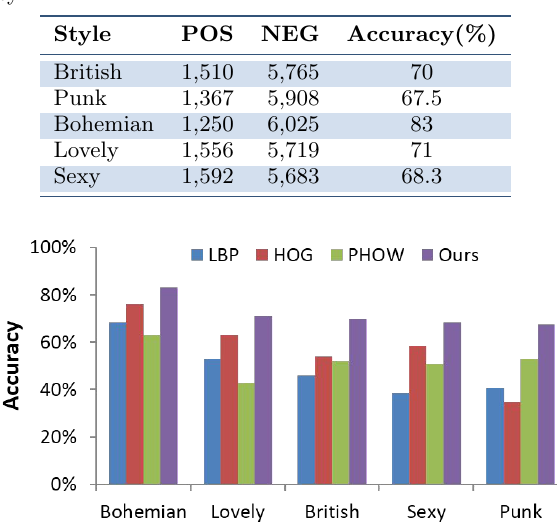
Table 2: The data information of styles and detection accu- racy